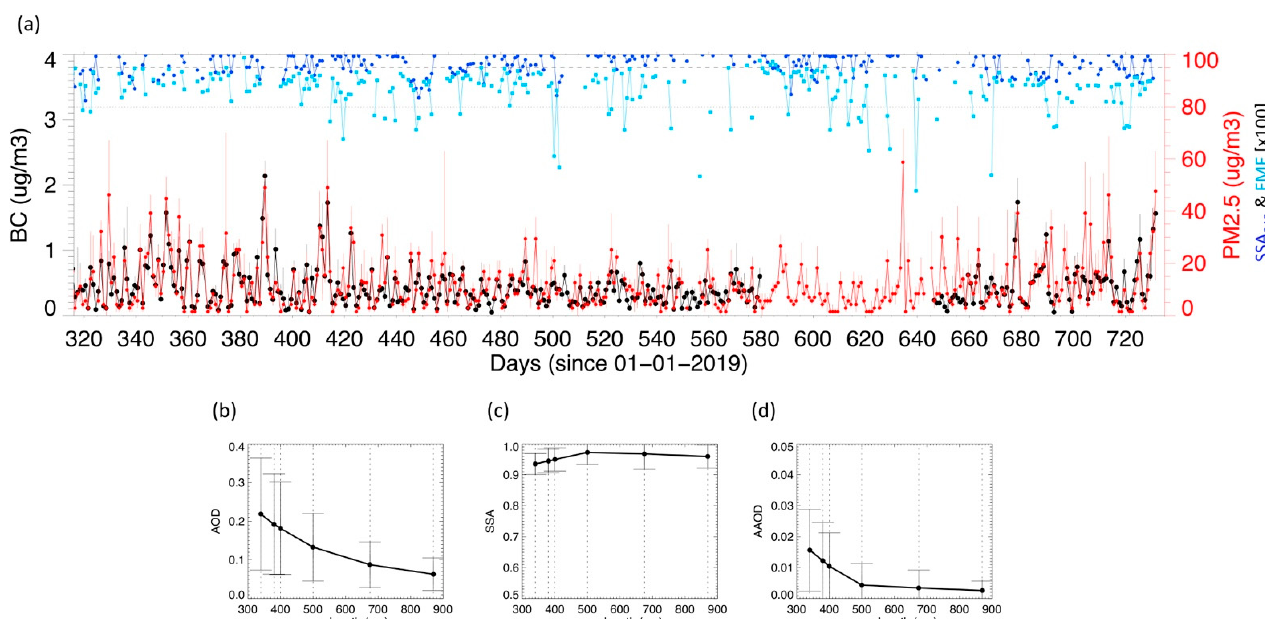
Figure 2. Main panel ( a ): time series of the daily surface BC (black line) and PM2.5 (red line in the opposite axis) mass concentrations recorded at Chiba University, from 12 November 2019 to 31 December 2020. Error bars show the 67% ranges of BC and PM2.5, respectively. The SSA at 340 nm (violet points) and fine-mode fraction (FMF) of aerosol particles with a diameter of <2.5 µm (i.e., F2.5; cyan squares) estimates are shown on the opposite axis (expressed as values × 100). Bottom panels: mean AOD ( b ), SSA ( c ), and AAOD ( d ) over the investigation period retrieved by sky radiometer observations at 340, 380, 400, 500, 675, and 870 nm. Error bars show the standard deviation.